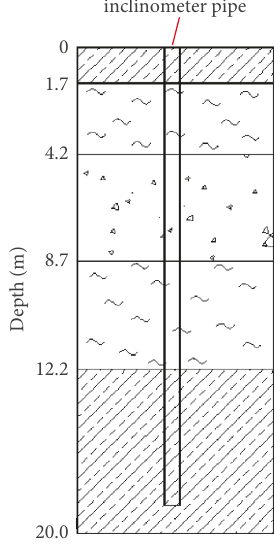
Figure 7: Section stratum section diagram.